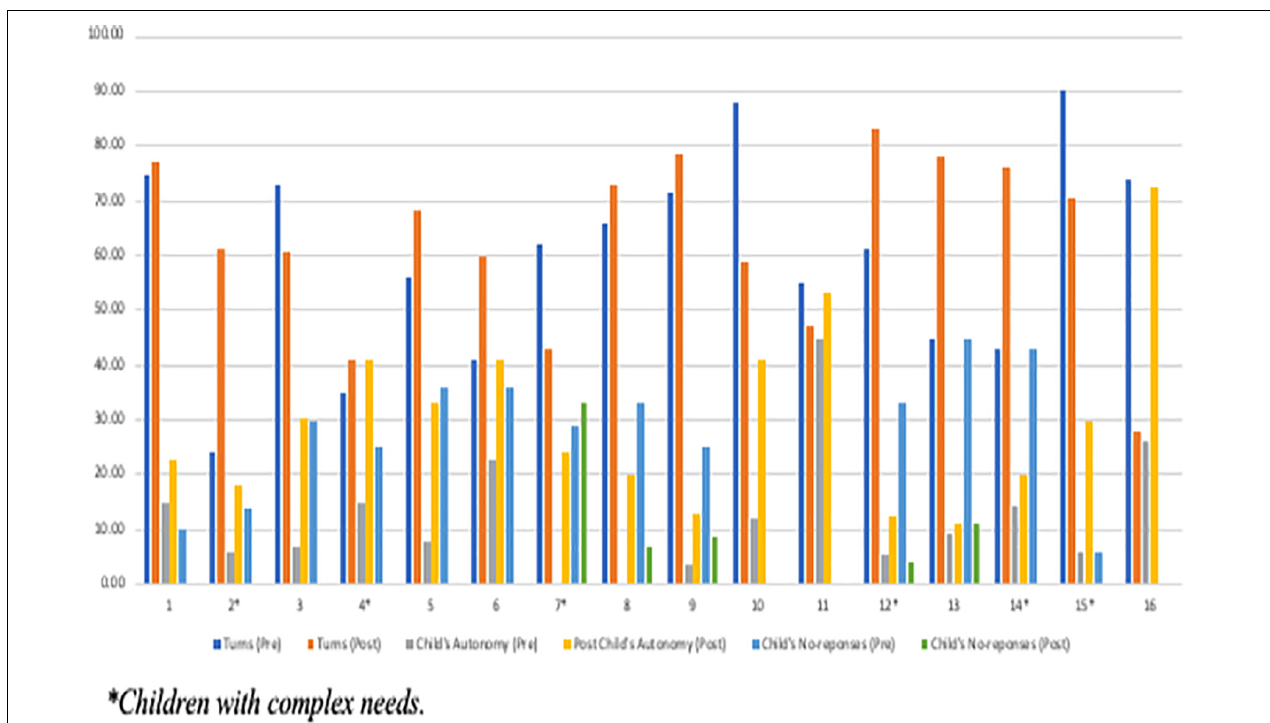
FIGURE 3 | Case-by-case scores at pre- and post-intervention on the Tait video analysis.